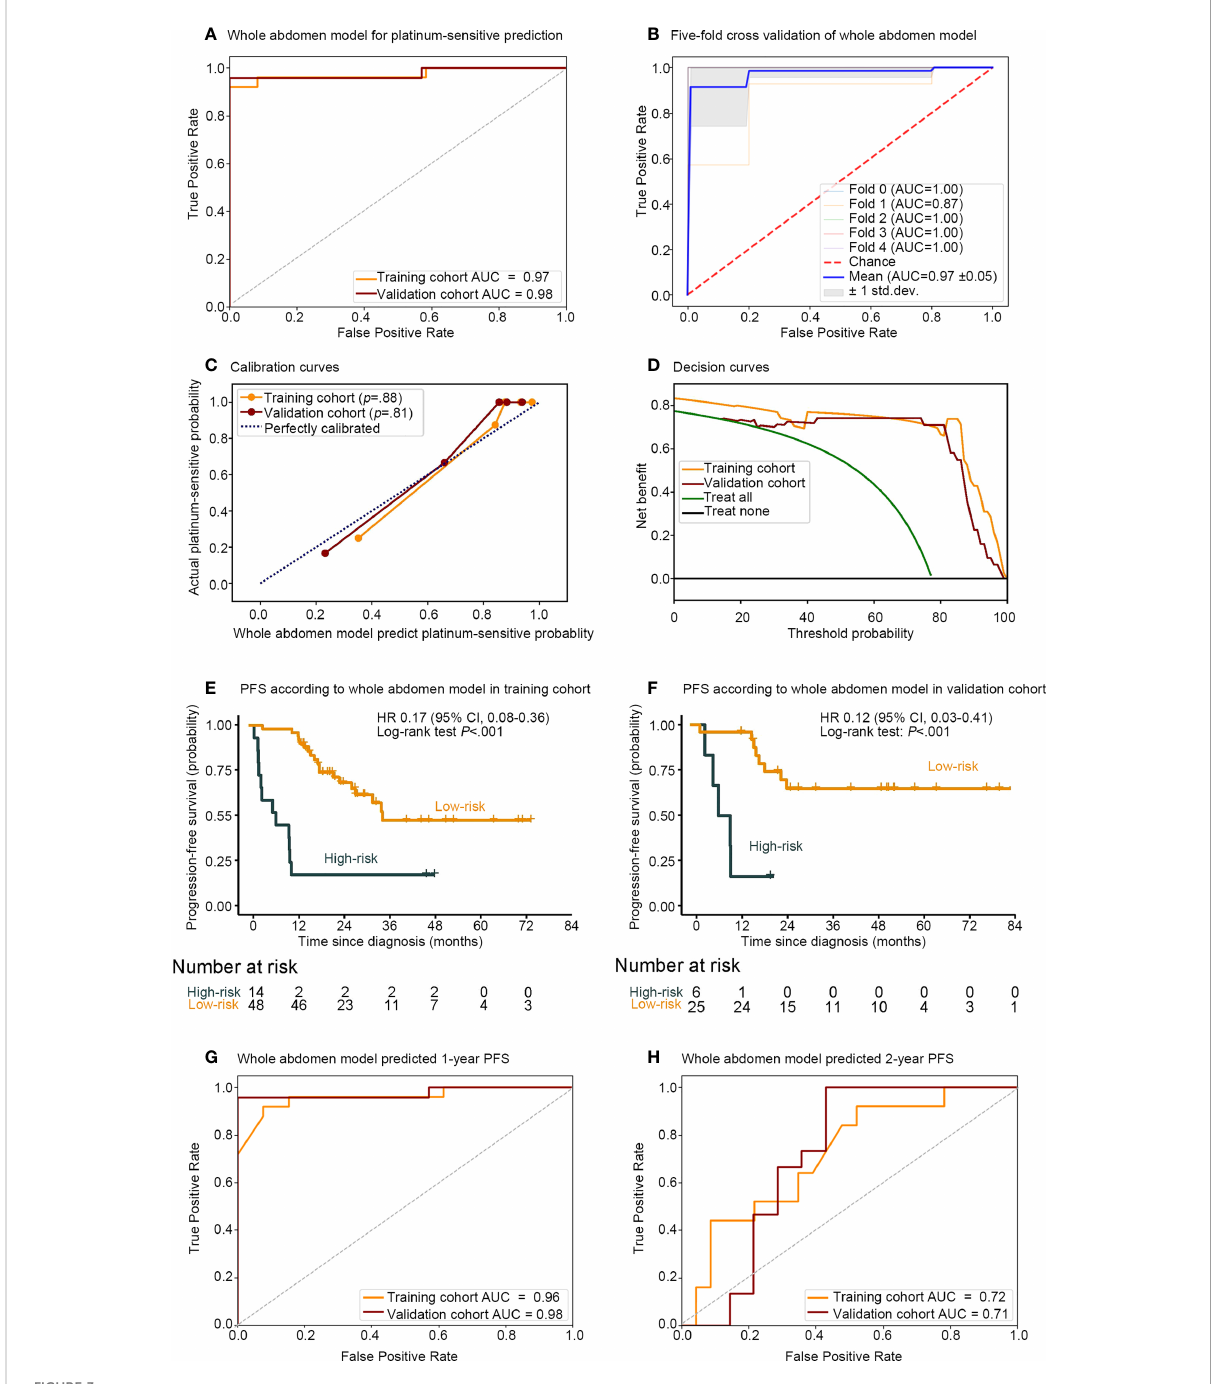
FIGURE 3 Performance of whole abdomen model including association between the whole abdomen model decision function value and the PFS. Receiver operating characteristic (ROC) curves (A) of whole abdomen model performance for predicting platinum sensitivity; (B) fi ve-fold cross- validation, and evaluation with (C) calibration curve; (D) decision curve. Kaplan – Meier curves of PFS according to the decision function value in 93 patients split into high- and low-risk groups from both the (E) training and (F) validation cohorts by cutoff values of 0.296 and − 1. ROC curves and (G) 1-, (H) 2-, year AUCs were used to assess the prognostic accuracy of the whole abdomen model. PFS, progression-free survival; ROC, receiver operating characteristic; AUC, area under the receiver operating characteristics curve; HR, hazard ratio; CI, con fi dence interval; P values were calculated using the unadjusted log-rank test, and hazard ratios were calculated by a univariate Cox regression